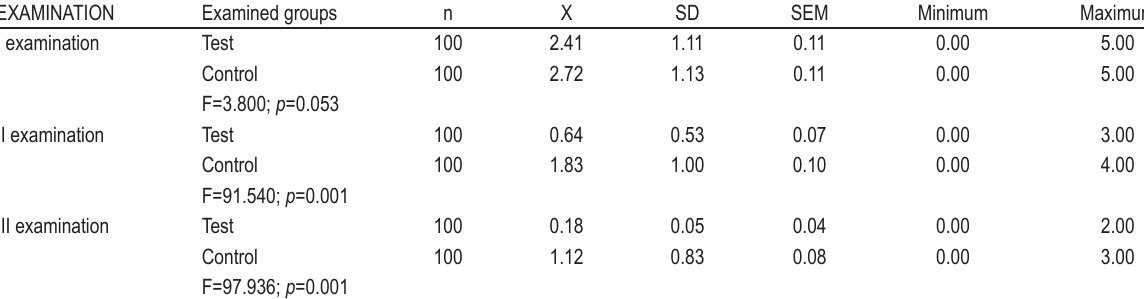
TABLE 6. Analysis of the ability to maintain a standing position in both examined groups